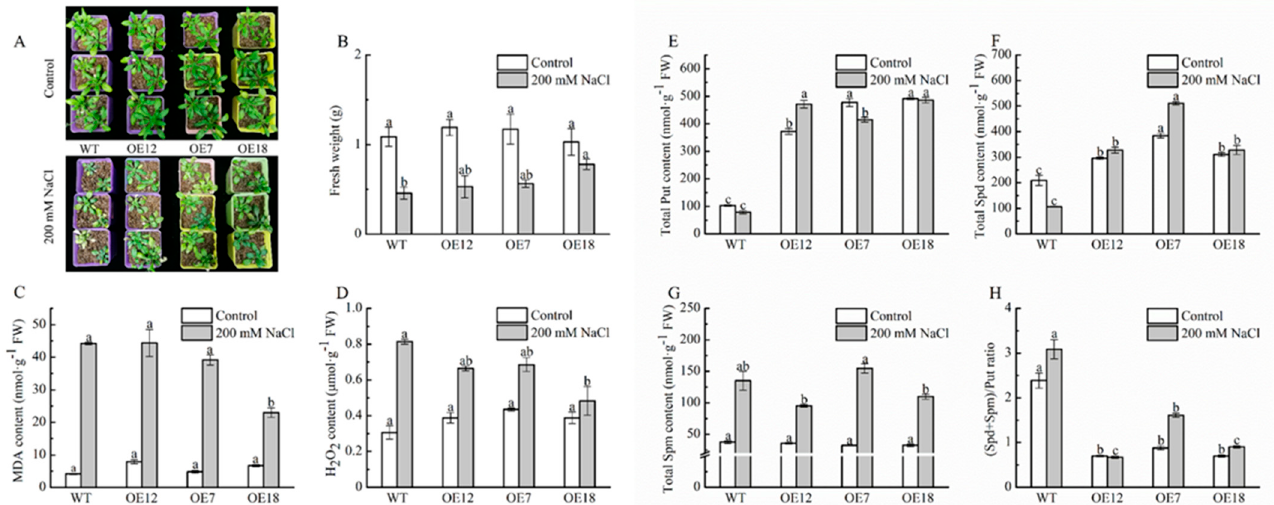
Figure 1. Plant growth ( A , B ) MDA, ( C ) H 2 O 2 content, ( D ) polyamine content, ( E – H ) in leaf of wild type (WT) and transgenic Arabidopsis lines (OE7, OE12 and OE18). ( E ) Put; ( F ) Spd; ( G ) Spm; ( H ) (Spd+Spm)/Put ratio. Arabidopsis seedlings cultivated in vermiculite were irrigated with normal water or water containing 200 mM NaCl for 14 days. The different letters indicate significantly different test index values between different genotypes under the same treatment ( p < 0.05) according to Tukey’s test.